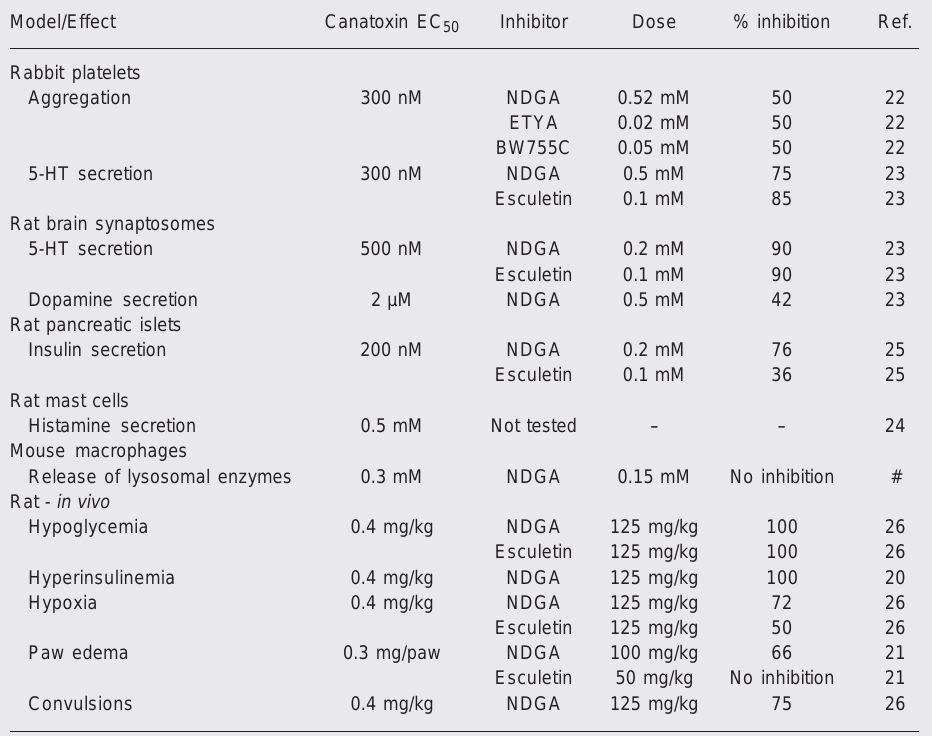
Table 1. Modulation of canatoxin-induced effects by inhibitors of the lipoxygenase